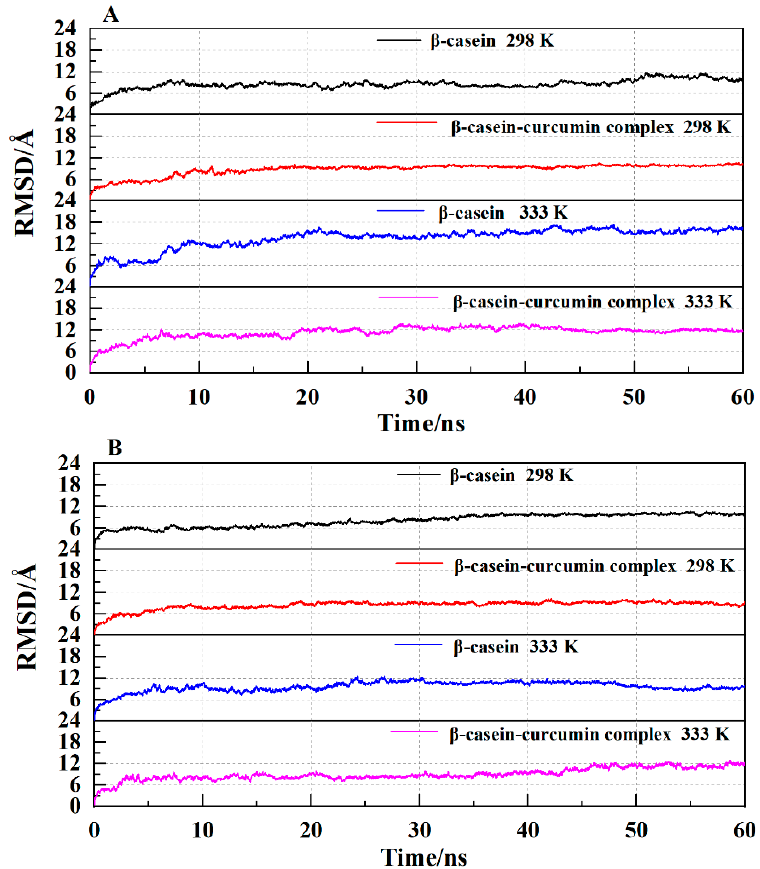
Figure 5. The backbone RMSD of β -casein in the absence/presence of curcumin at pH 7.4 ( A ) and pH 2.0 ( B ).